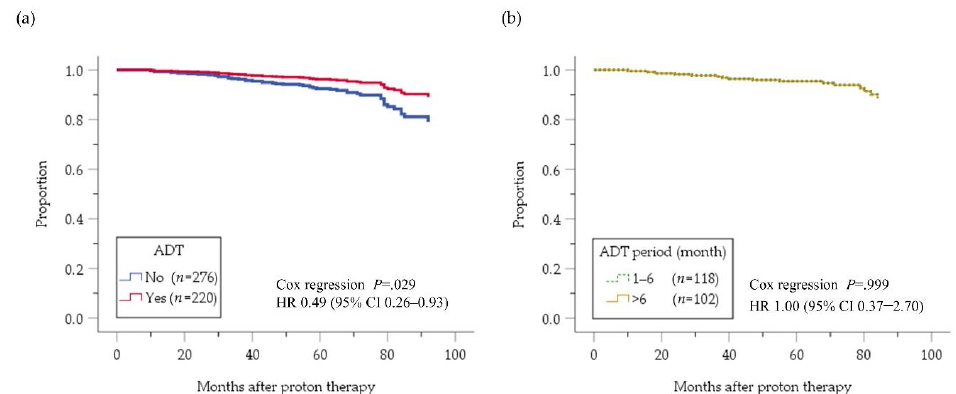
Figure 2. Cumulative bRF survival function adjusted by risk factors of intermediate-risk PC patients; with and without ADT ( a ) and with ADT for 1–6 months and >6 months ( b ). bRF, biochemical relapse-free; ADT, androgen deviation therapy; HR, hazard ratio; CI, confidence interval.